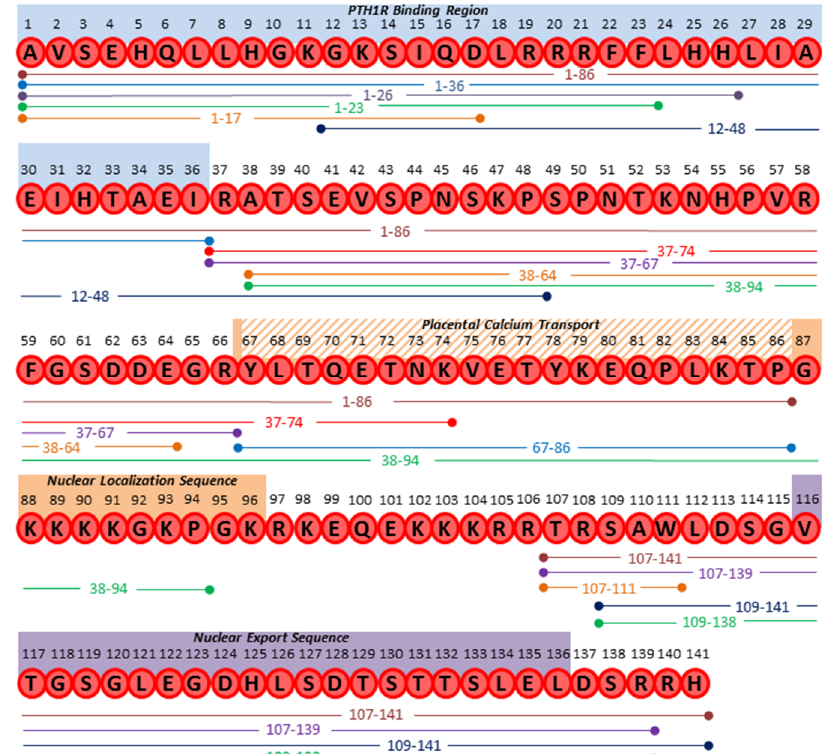
Figure 2. Multiple residues within the PTHrP sequence serve as putative sites for proteolytic cleavage. Currently known PTHrP fragments are shown beneath the amino acid sequence, demonstrating the presence of common residues involved in the generation of these fragments. Functional protein domains are illustrated above the sequence, including the PTH1R binding region (aa. 1–36, blue), placental calcium transport region (aa. 67–86, orange stripes), nuclear localization sequence (aa. 67–96, orange), and nuclear export sequence (aa. 116–136, purple).